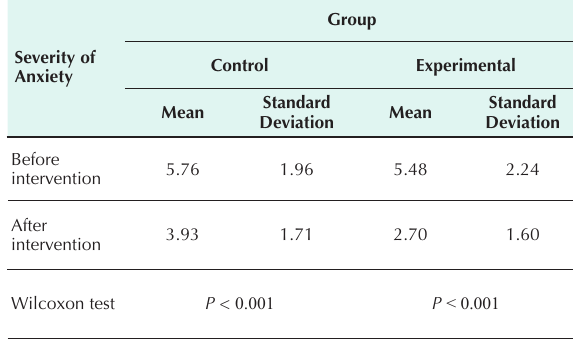
Table 1. Numerical Indices of Anxiety in Studied Patients in Experimental and Control Groups and the Comparison of the Averages in the First Day in 2017